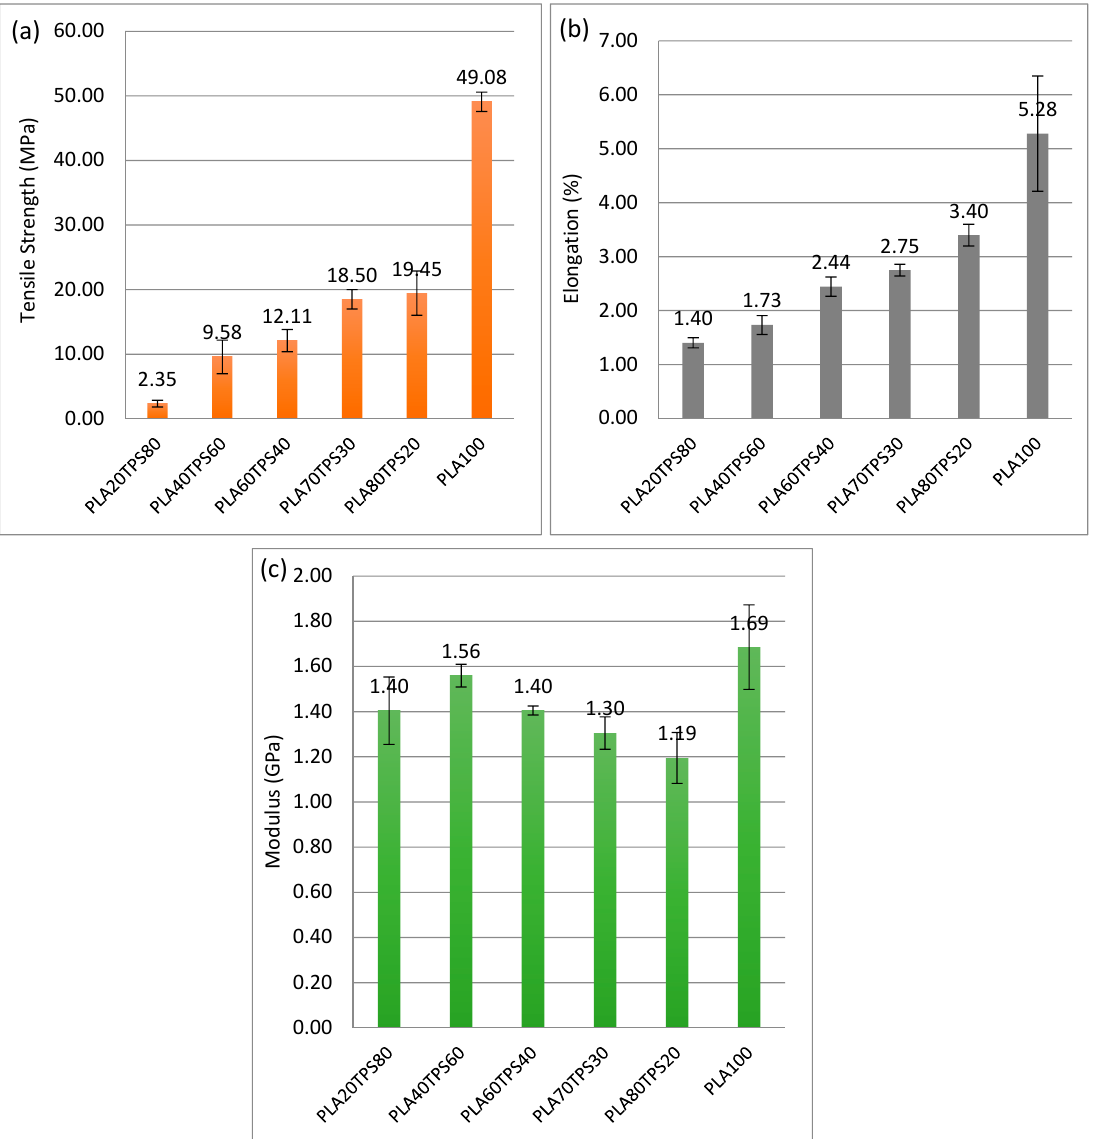
Figure 6. ( a ) Tensile strength, ( b ) elongation at break, ( c ) Young’s modulus of PLA100 and PLA/TPS blend bionanocomposites.